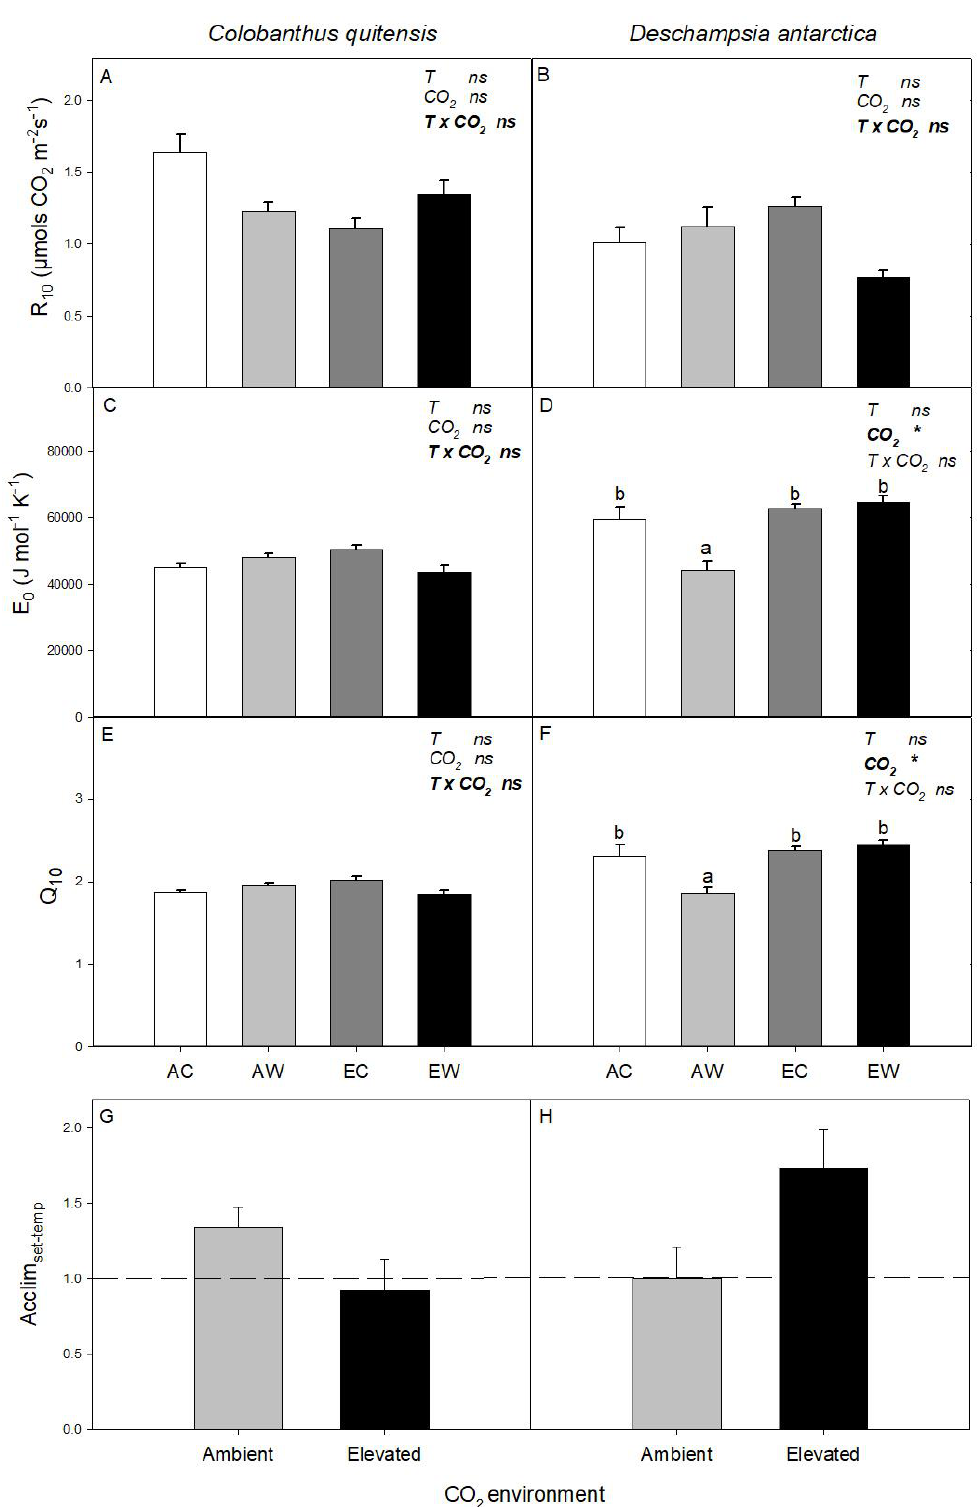
Figure 2. Sensitivity parameters of dark respiration calculated using the Arrhenius equation for both Antarctic species. R 10 is respiration at 10 ◦ C, E 0 is a modelled parameter related to the energy of activation, and Q 10 denotes the relative change in respiration with a 10 ◦ C change for C. quitensis ( A , C , E ) and D. antarctica ( B , D , F ). Treatments correspond to AC (ambient CO 2 , control